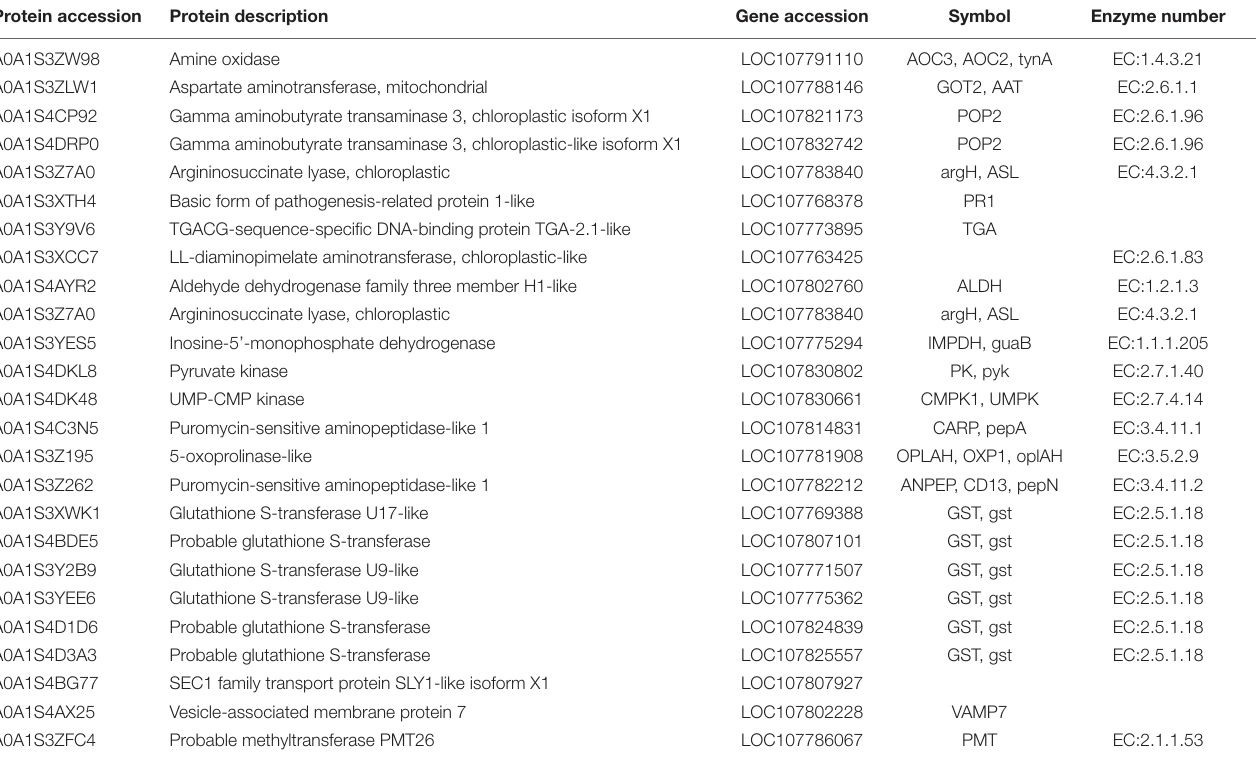
TABLE 2 | Description information of the key proteins of nicotine synthesis. Protein accession Protein description Gene